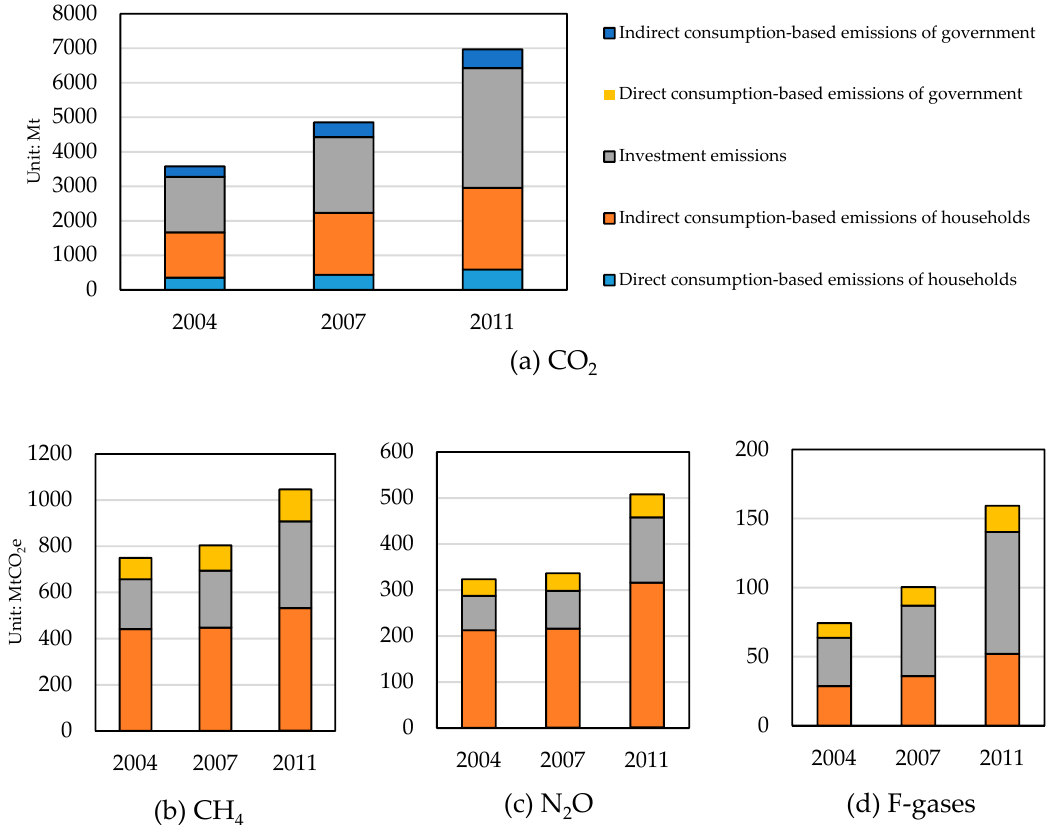
Figure 2. Composition of China’s consumption-based ( a ) CO 2 , ( b ) CH 4 , ( c ) N 2 O, and ( d ) F-gases in 2004, 2007, and 2011.